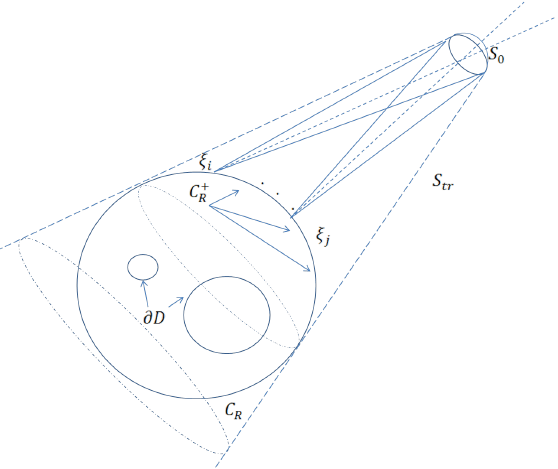
Figure 8. The region of influence of the data confined on S 0